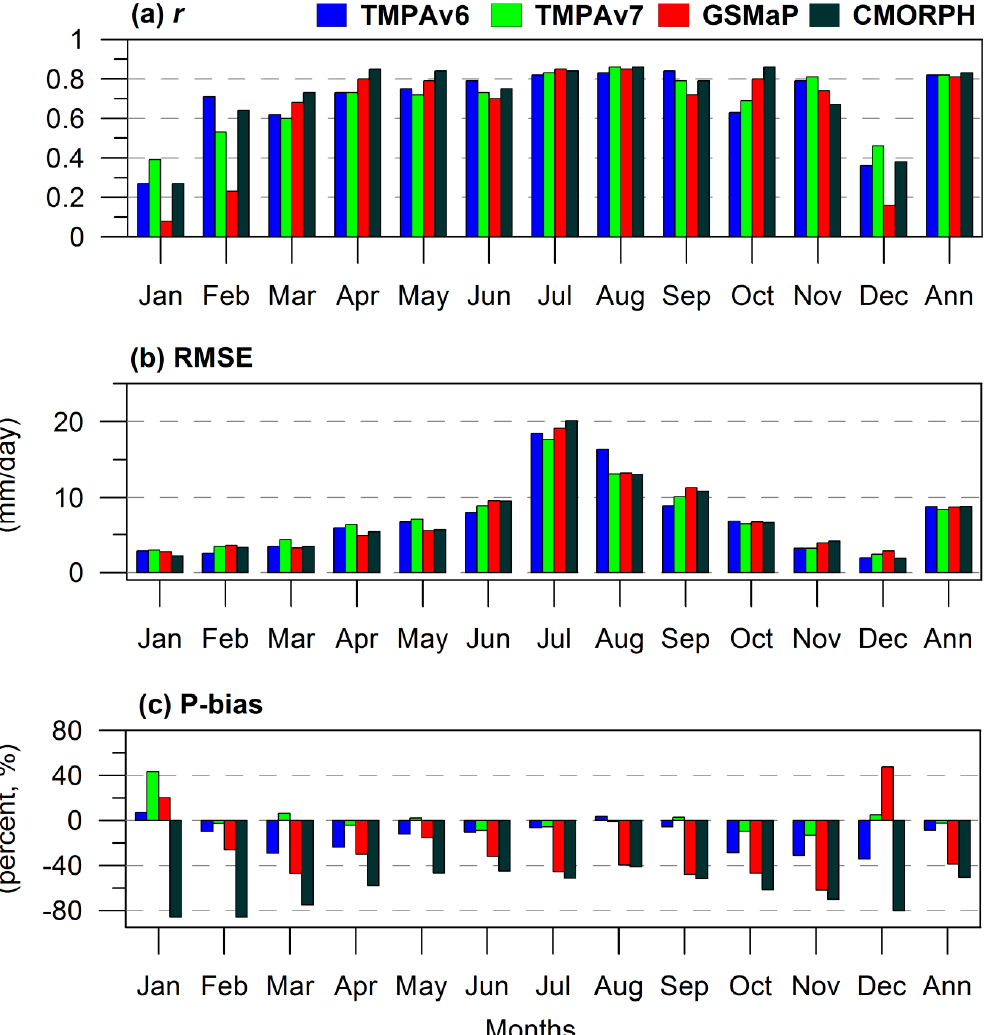
Figure 3. Monthly mean correlations, RMSE, and p-bias over 2002–2009 between basin-averaged precipitation from TMPAv6, TMPAv7, GSMaP, CMORPH and gauged estimates over the Soyang dam basin. ( a ) r ; ( b ) RMSE and ( c ) P-bias.